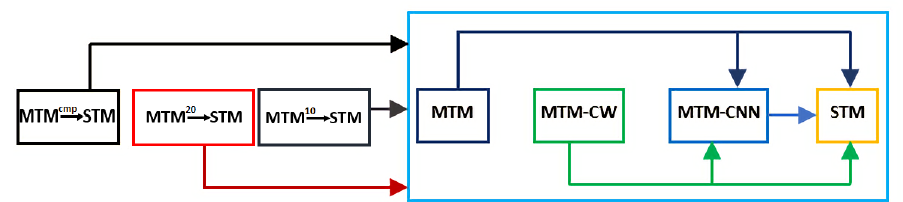
Figure 12. Graphical representation of Friedman test ranks produced by MTM → STM . Models are shown according to their ranks starting with the best model from left to